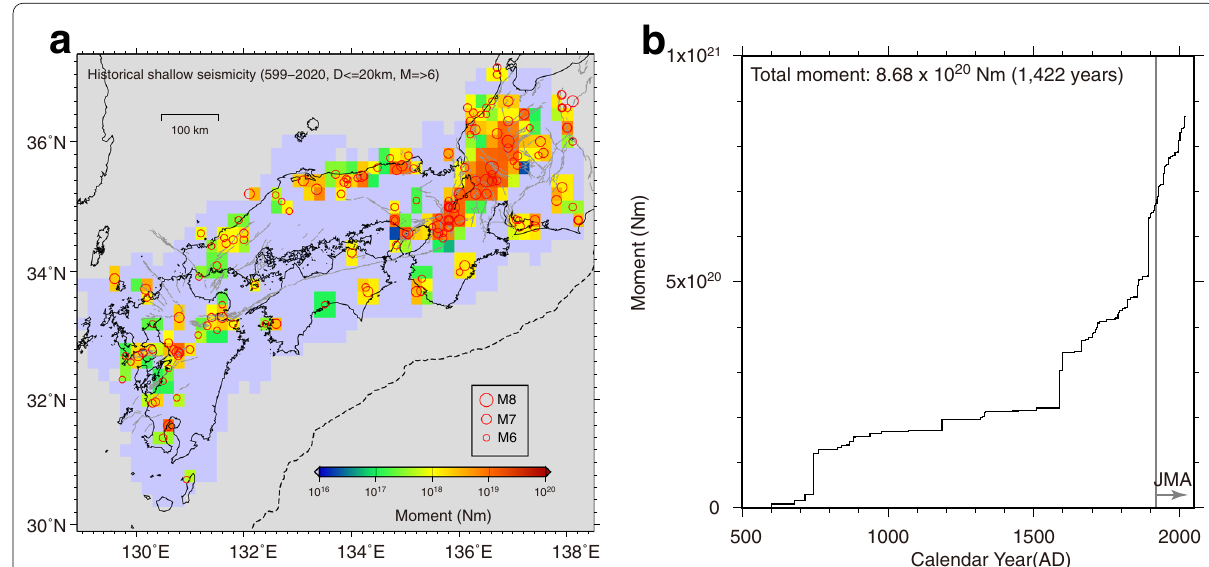
Fig. 3 Seismic moment of past M 6 crustal earthquakes from 599 to 2020. a Moment distribution of earthquakes in 0.2º cells. Red circles indicate ≥ epicenters of earthquakes. b Moment evolution of earthquakes. Note that the seismic catalogue is based on historical documents for 599–1918 (Utsu., 1990; 2002) and instrumental seismograms from 1919 (Japan Meteorological Agency 2022)